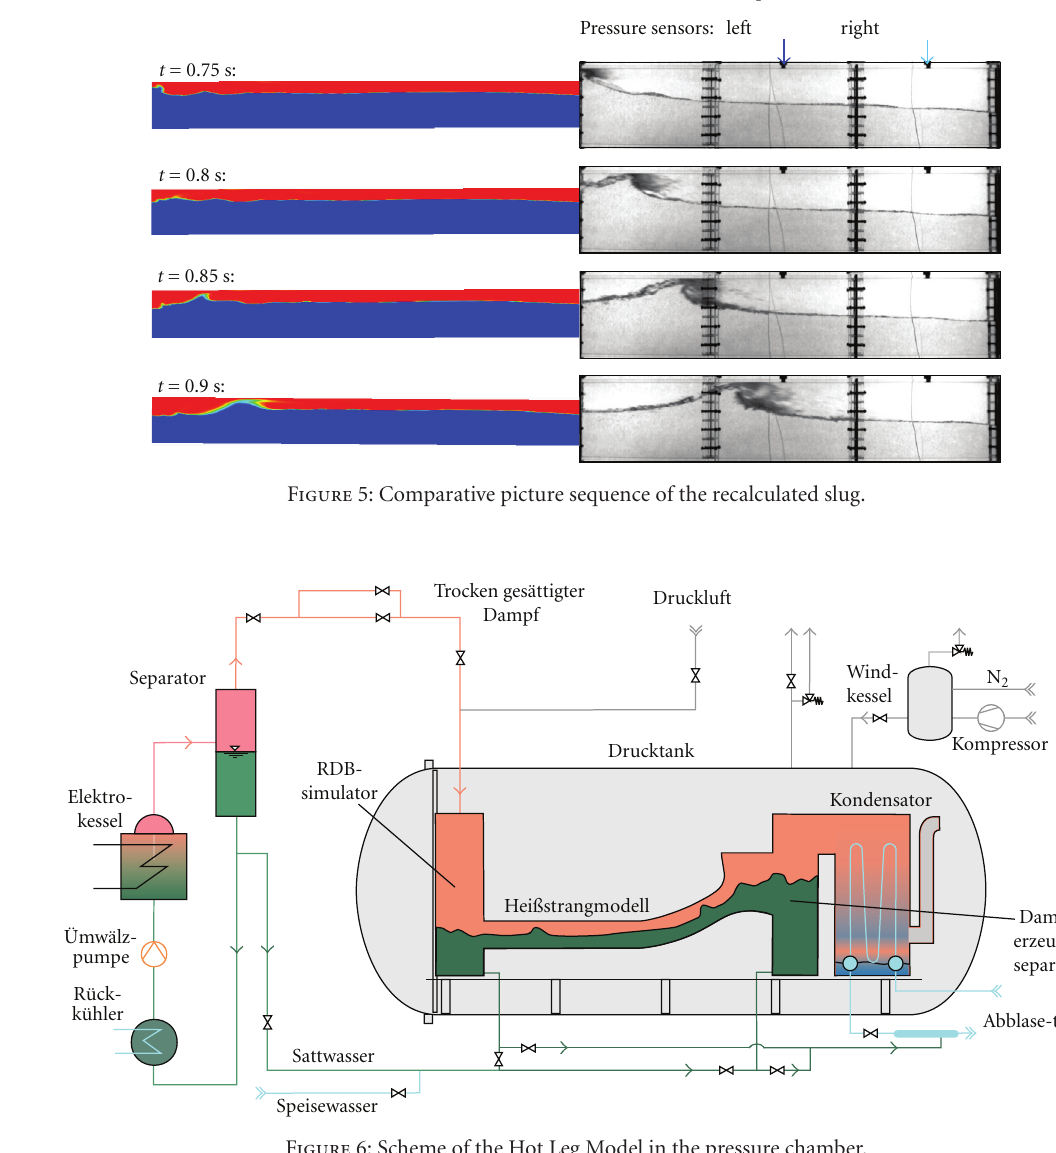
Figure 6: Scheme of the Hot Leg Model in the pressure chamber.